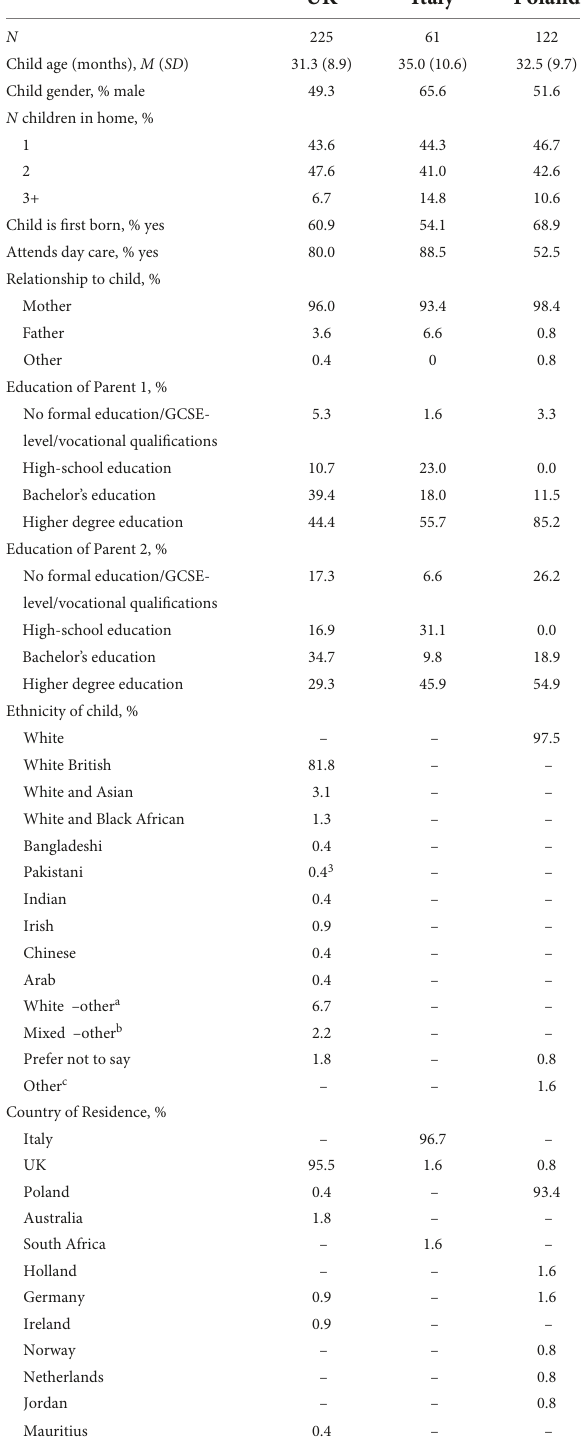
TABLE 2 Participant demographic